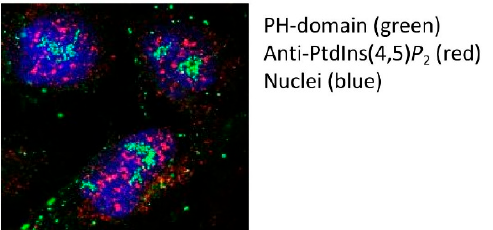
Figure 3. U2OS cells were fixed with 4% paraformaldehyde and permeabilised with PBS 0.1%TX-100 for 5 minutes. Nuclei were then incubated with bacterially expressed and purified GFP-PLC δ 1 PH domain (green) and with the antibody (2C11) targeted to PtdIns(4,5) P 2 (red staining). Nuclei were stained with DAPI (blue). The images from single channels were merged in Image J. Note the lack of overlap between the two types of PtdIns(4,5) P 2 probes.